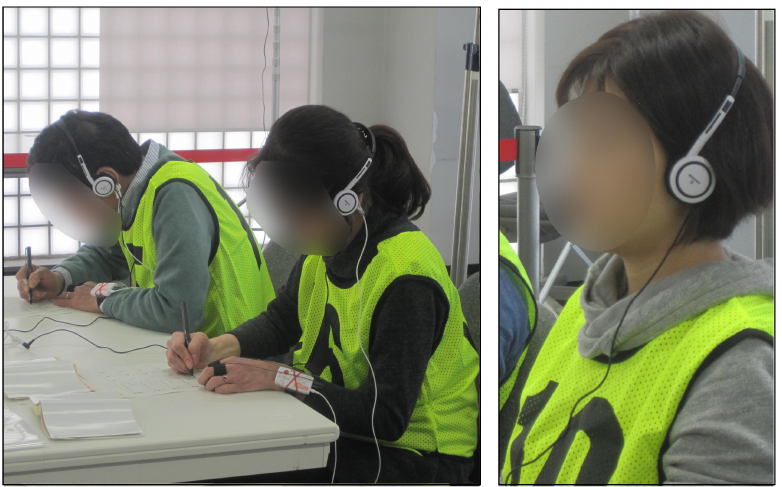
Figure 1. Two subjects during the cognitive load session. Left : reporting the results of the math calculation. Right : during the audio listening